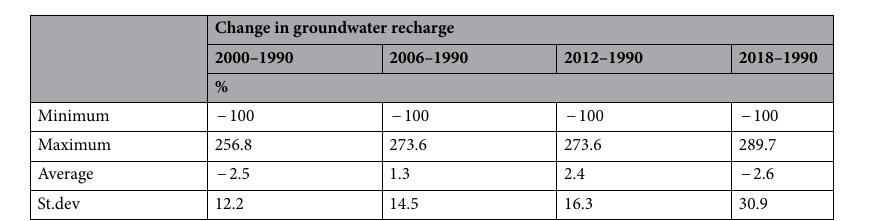
Table 3. Minimum, maximum, average, and standard deviation values of the change in groundwater recharge in % of the simulated LULC scenarios (2000, 2006, 2012 and 2018) with respect to the base LULC in 1990.